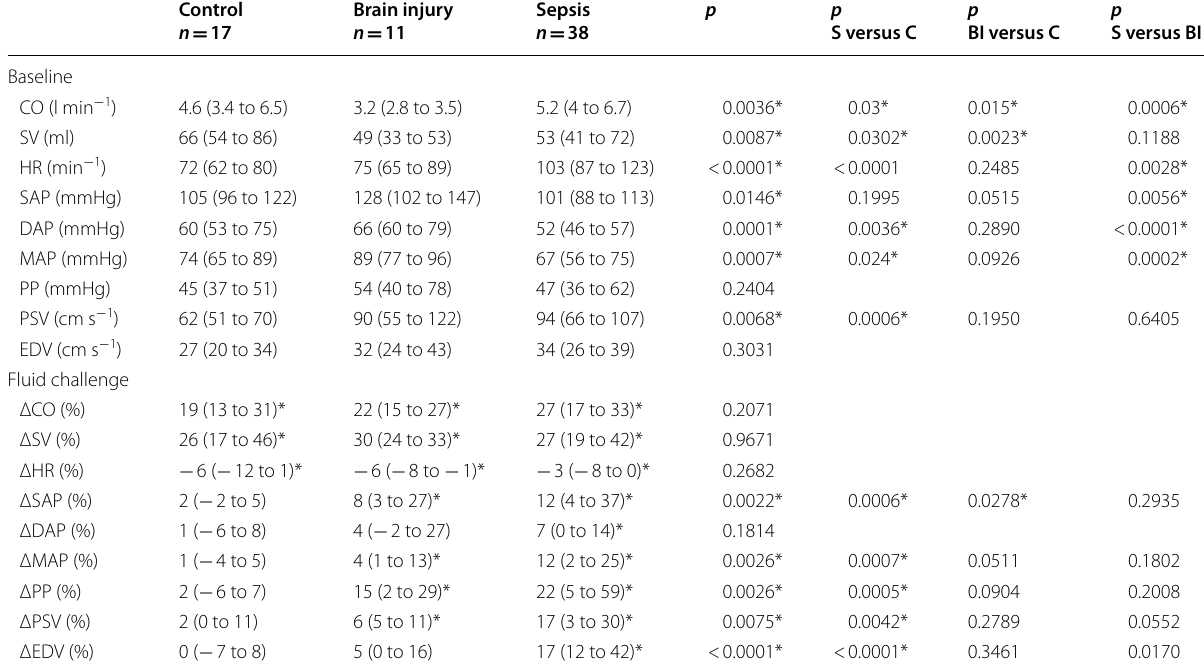
Table 2 Systemic and cerebral